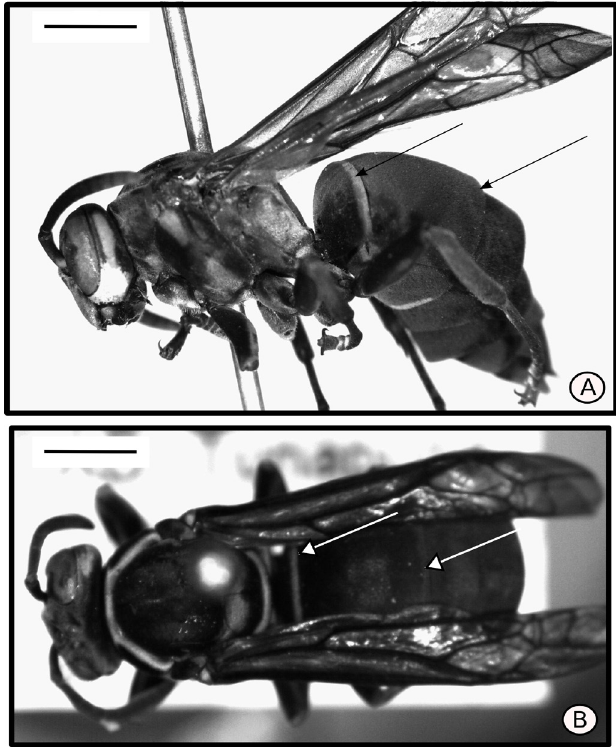
Fig 2 . Worker of Chartergellus trinitatis (A) lateral view; (B) dorsal view. Arrows pointing to yellow bands on metasoma. Scale bar = 2.0